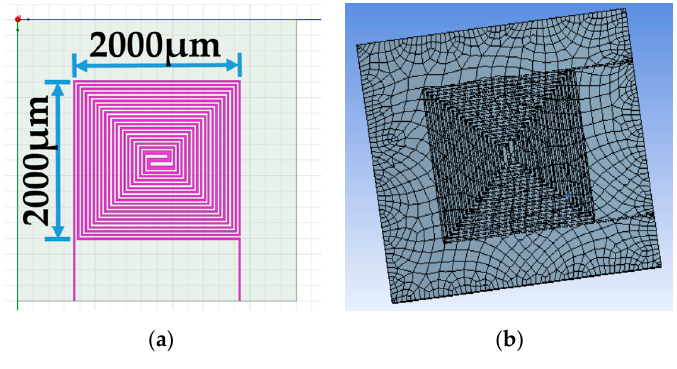
Figure 2. (a) Double spiral heater of simulation model. (b) Meshed solid model for the thermal-electric simulation.